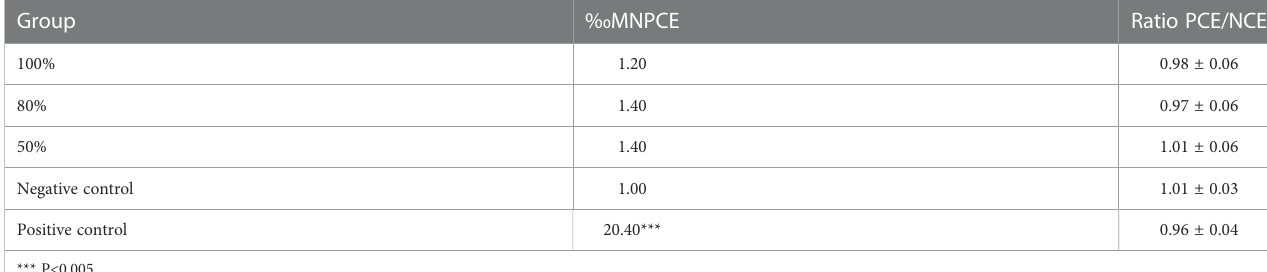
TABLE 1 Genotoxicity of the novel hydrogel.